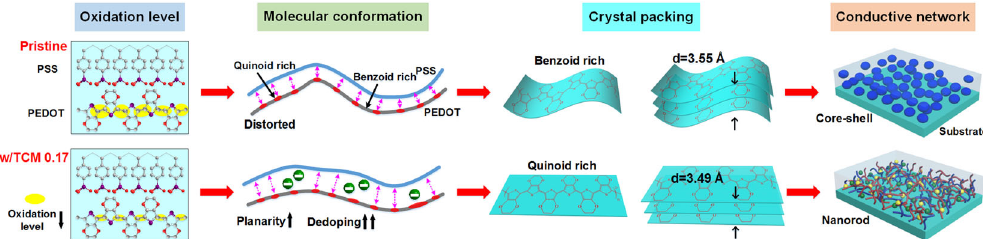
Fig. 6 Multi-length scale structure of PEDOT:PSS. Schematic diagram of multi-length scale structure of the pristine and IL-mixed PEDOT: PSS fi lms.